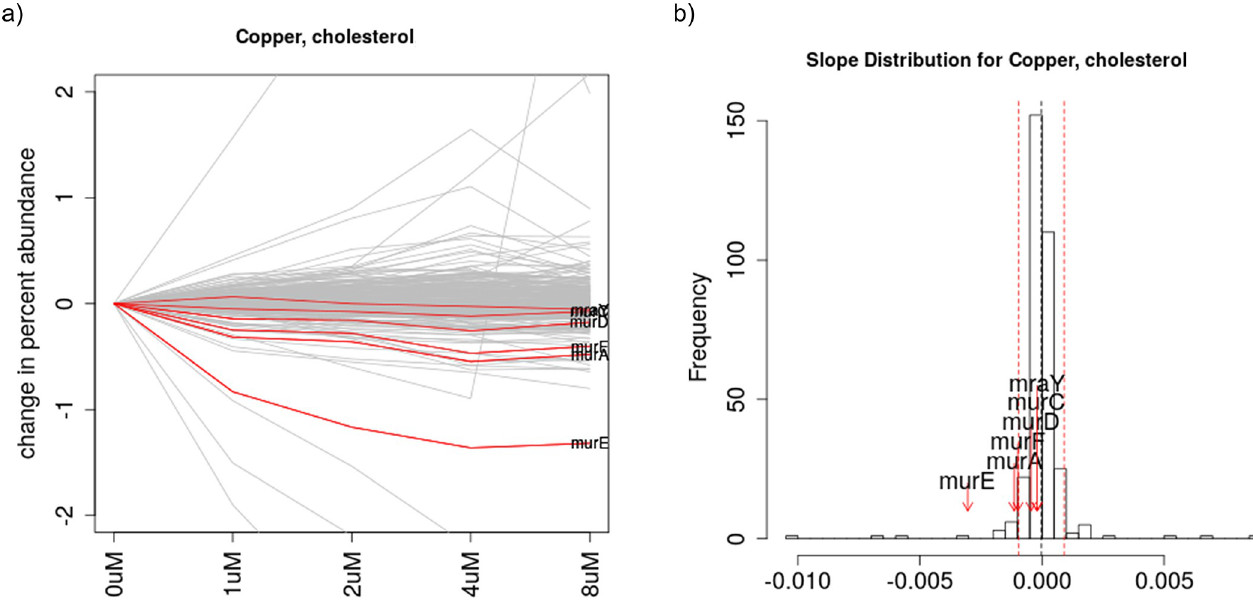
Fig 5. Abundance plot and slope histogram for genes in an M . tuberculosis hypomorph library treated with copper. Six genes of the muramic acid pathway, which is required for peptidoglycan synthesis, are highlighted in red, indicating increased sensitivity of this pathway with increasing concentrations of